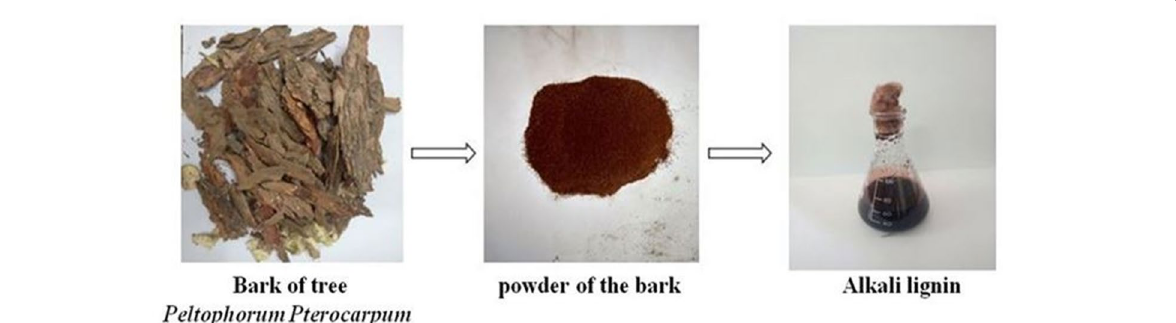
Fig. 1 Preparation of alkaline lignin